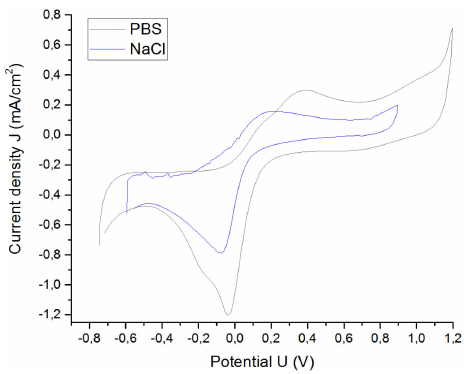
Figure 13. Cyclic voltammetry (CV) of the Pt cu ff electrode G in PBS and NaCl solutions.